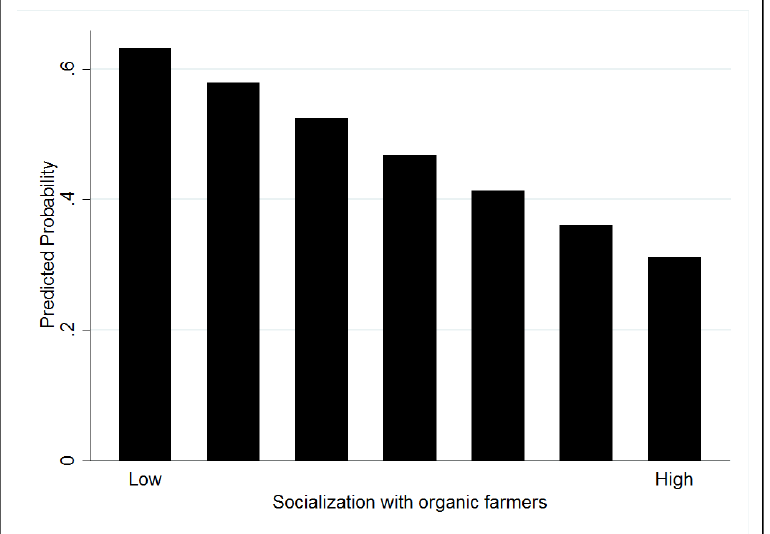
Figure 2. Predicted Probability of Adopting Organic Farming Practices as a Function of Socialization with Organic Farmers All other variables are held at their mean using model 2